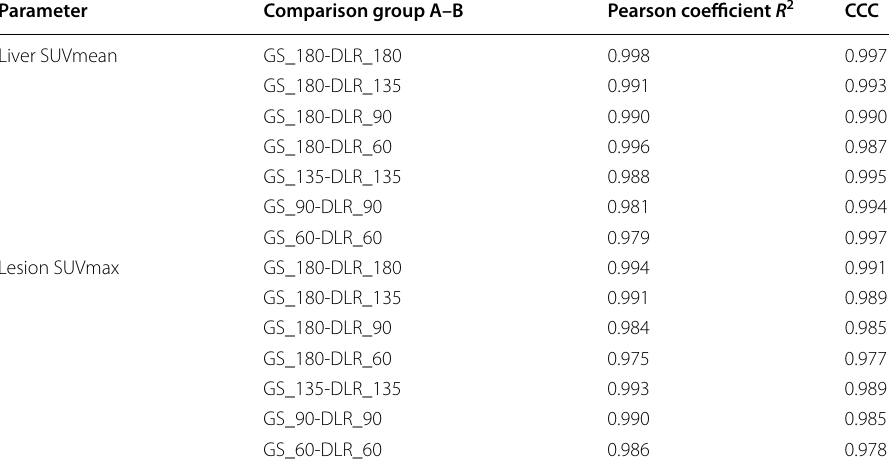
CCC, concordance correlation coefficient; SUV, standardized uptake value